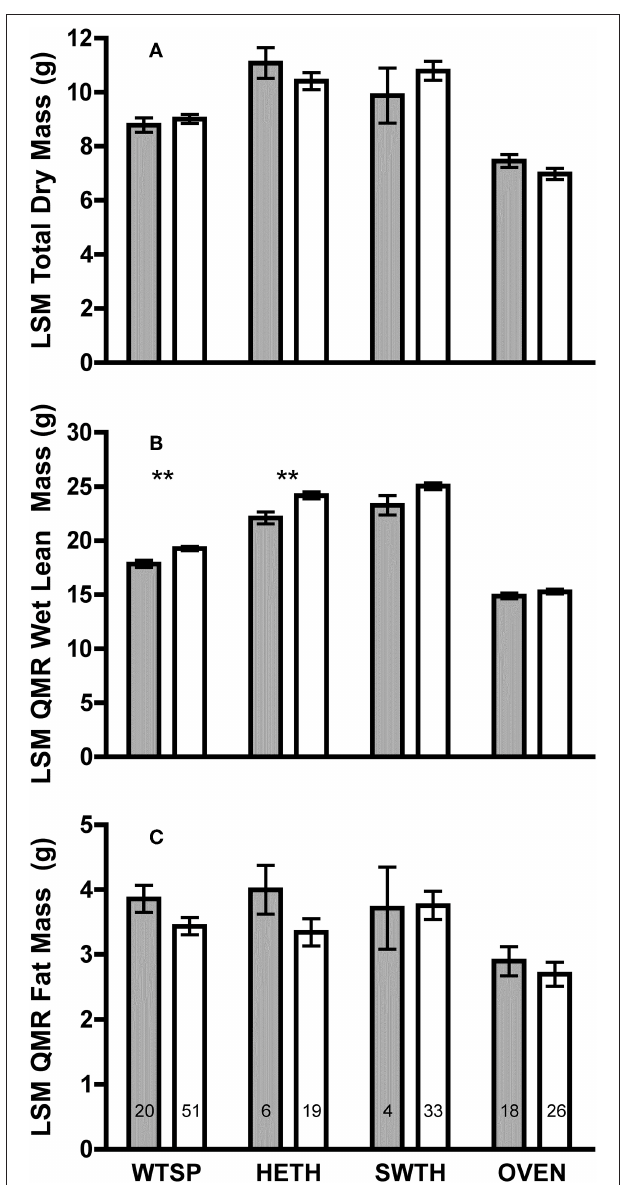
FIGURE 1 | Least square means ( ± SE) (A) total dry mass; (B) QMR wet lean; and (C) QMR fat masses from ANCOVA using SizePC1 as a covariate of adult (gray bars) and juvenile (white bars) white-throated sparrow (WTSP), hermit thrush (HETH), Swainson’s thrush (SWTH), and ovenbird (OVEN). SizePC1 is a principal component containing tarsus and keel measurements for hermit thrush, Swainson’s thrush, and ovenbird, and tarsus, keel, and bill measurements for white-throated sparrow. Numbers within bars indicate sample sizes for each group. Asterisks denote differences between juveniles and adults at P < 0.01 (**). throated sparrows [ F (1,67) = 10.50, P = 0.002], Swainson’s thrushes [ F (1,34) = 7.55, P = 0.01], and ovenbirds [ F (1,41) =